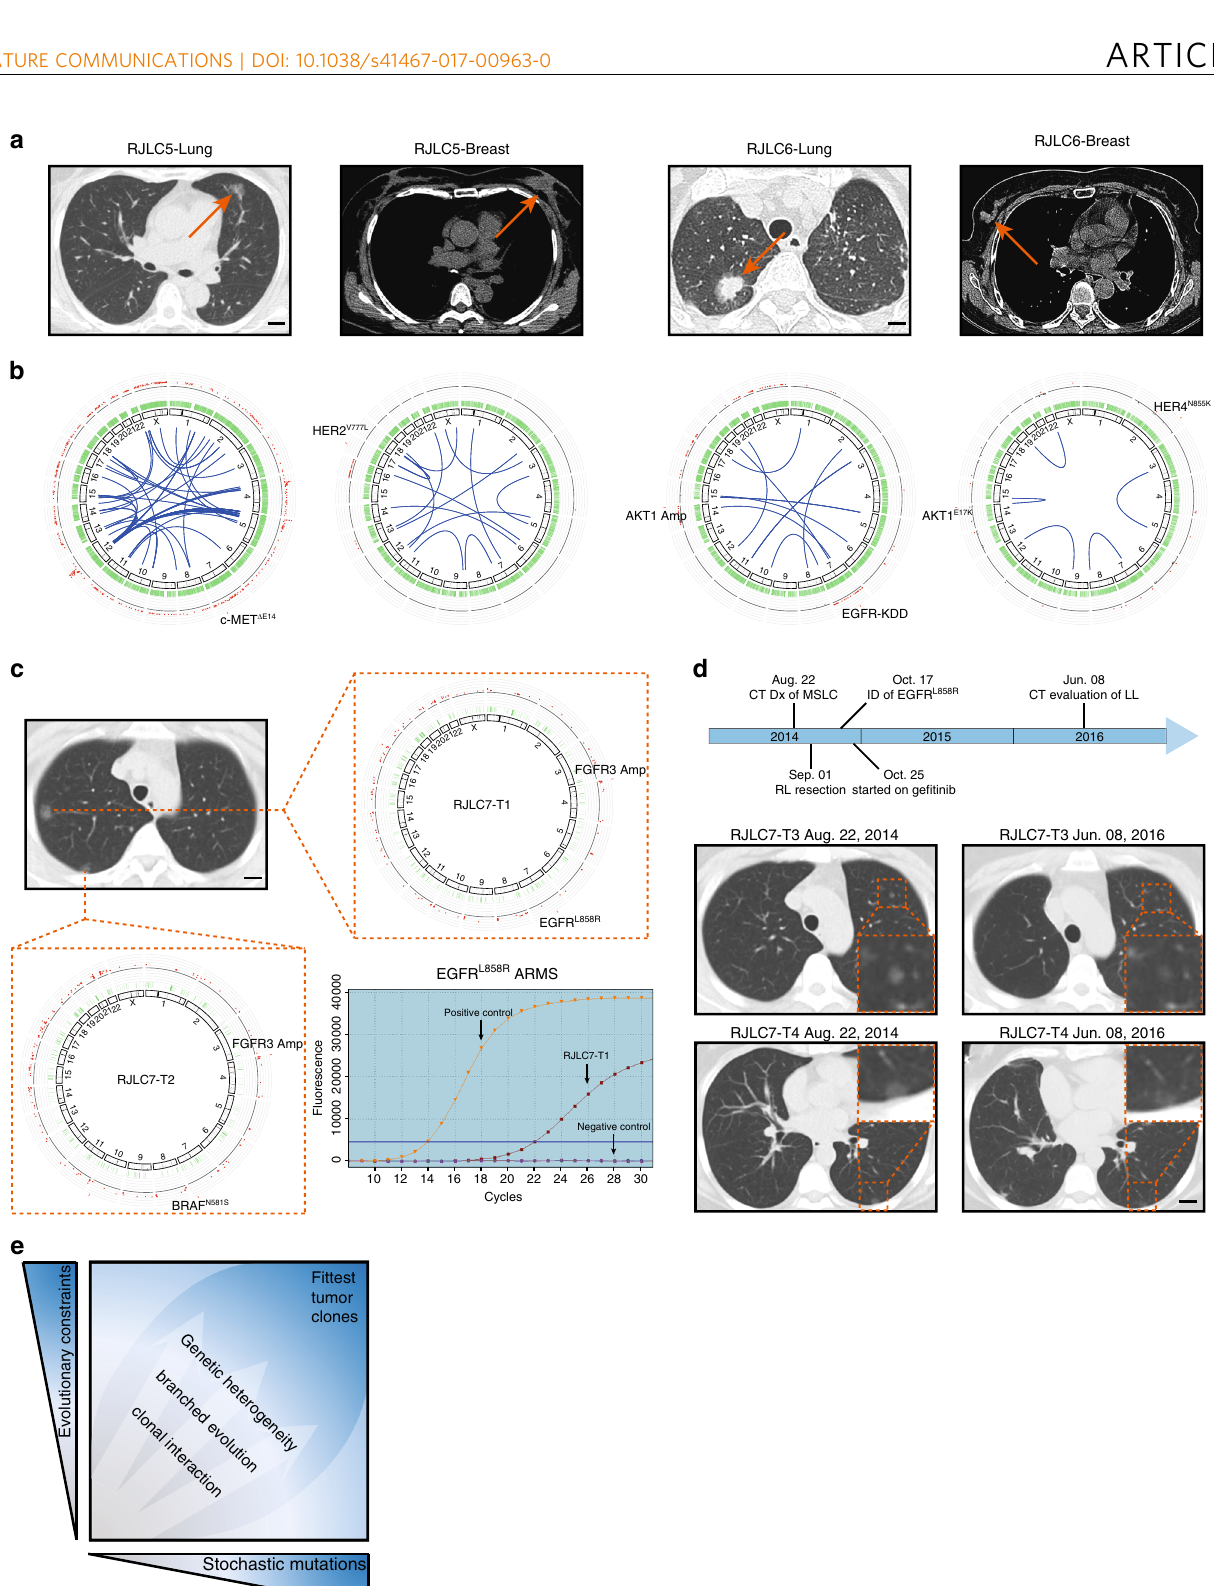
Fig. 4 Independent validation of oncogenic pathway convergence. a CT diagnosis of synchronous lung and breast tumors in RJLC5 and RJLC6. Scale bar, 1 cm. b Circos plots highlighting different structural variations of lung and breast tumors in RJLC5 and RJLC6. RJLC5-Lung harbored c-MET Δ E14 and RJLC5- Breast harbored HER2 Y777L ; RJLC6-Lung harbored EGFR-KDD and RJLC6-Breast harbored HER4 N855K . c CT diagnosis of MSLC and circos plots representation of somatic mutations in RJLC7. EGFR L858R identi fi ed in RJLC7-T1 was con fi rmed using ARMS PCR. Scale bar, 1 cm. d Time line of RJLC7 MSLC diagnosis and treatment. Baseline and 21-month CT scan for RJLC7 following treatment with ge fi tinib. Scale bar, 1 cm. e A schematic model showing that simultaneous evolutionary expansion and constraint of genomic heterogeneity collaboratively shape tumorigenic process and clonal